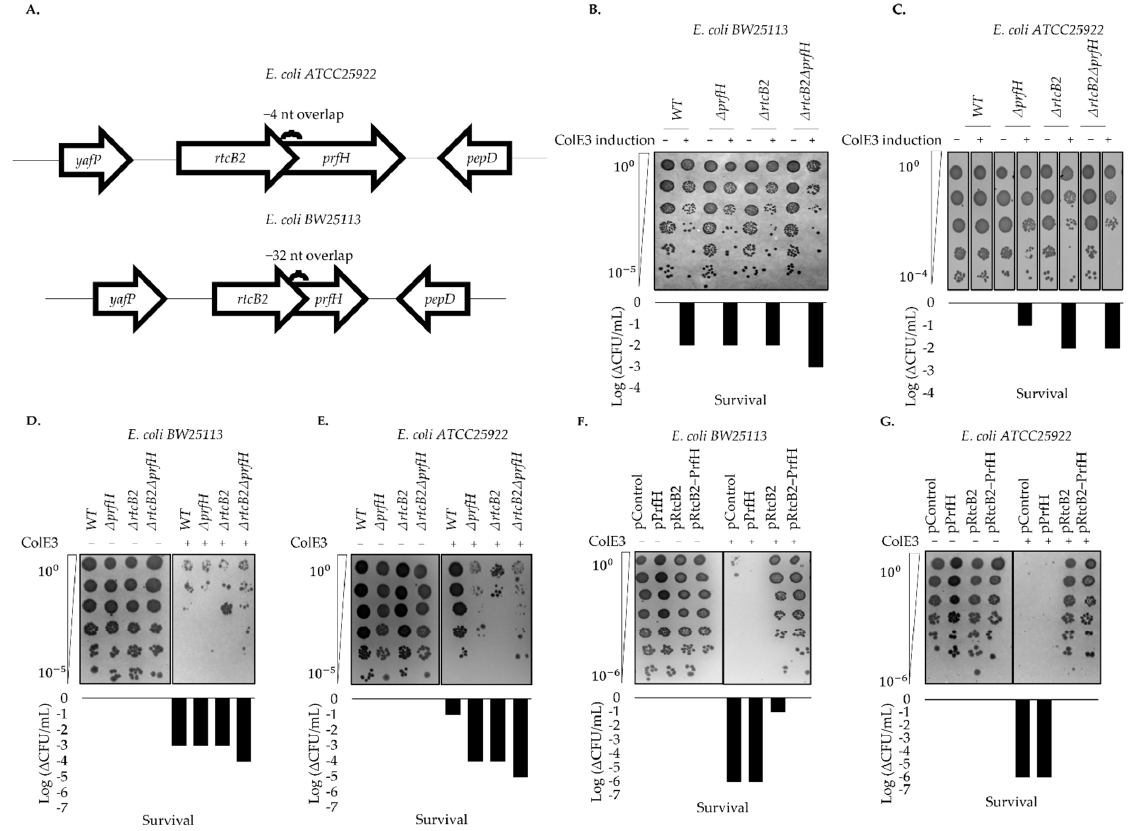
Figure 1. Action of colicin E3 on different E. coli strains. ( A ) Location of rtcB2 and prfH genes in the genome of E. coli strains used in the current study. The top and bottom regions show operon regions for E. coli ATCC25922 and BW25113 , respectively. Survival upon colicin E3 treatment is shown from ( B – G ). The results from ( B – G ) demonstrate a decline of cell titer after serial dilutions. ( B , C ) show in vivo testing of colicin E3 activity on wild-type and knockout strains after inducible expression of colicin E3 gene under tet promoter, executed for both E. coli BW25113 and E. coli ATCC25922 strains. Colicin E3 synthesis was induced with 0.2 µg/mL of anhydrotetracycline when cells had grown to log-phase. ( D , E ) are an in vivo test for the recombinant colicin E3 activity on wild-type and knockout strains for E. coli BW25113 and E. coli ATCC25922 , respectively. ( F , G ) is a demonstration of survival assay in rtcB2 - prfH double knockout cells, transformed by complementation plasmids in both E. coli BW25113 and E. coli ATCC25922 strains. For ( D – G ) the cleavage effect was induced upon treatment with 1 mg/mL of recombinant colicin E3 when cells reached log-phase. Milli-Q ultrapure water was used as a negative control for the experiment. Together, all these results were consistent and reproducible on repeat at least twice. Wherein a number of countable colonies (>10 colonies) from the most serially diluted spot scored in the survival assay, the order of magnitude difference was used to determine the decrease in cell growth between treated and corresponding untreated samples, respectively.